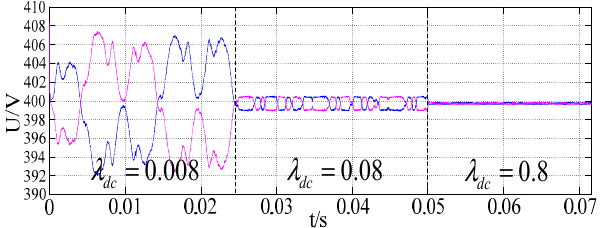
Figure 16. The influence of adjusting the weight factor of the capacitor voltage.